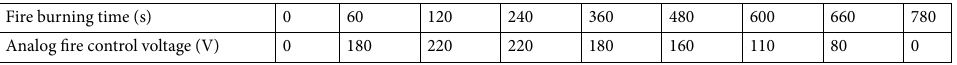
Table 1. Experimental simulation of fire source voltage editor settings.